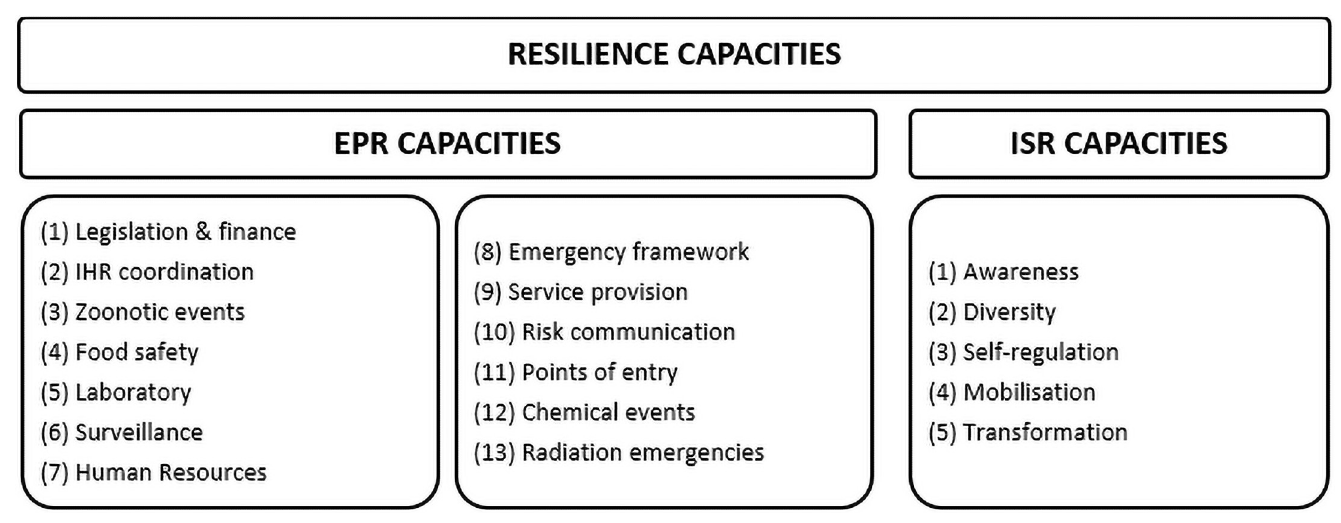
Fig 2. Capacities of health system